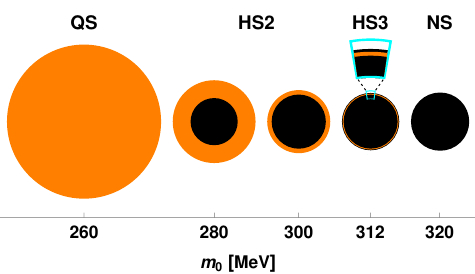
Figure 1 . An illustration of the structure of two-solar mass stars obtained for di(cid:11)erent values of m 0 . The chosen cases correspond to a QS, two di(cid:11)erent hybrid stars of type HS2, one HS3, and one ordinary NS. The orange (black) color represents quark (nuclear) matter, while the radii of the di(cid:11)erent circles are proportional to the actual sizes of the corresponding regions inside the stars. In (cid:12)gure 3, these (cid:12)ve stars are denoted by small crosses on the corresponding M { R